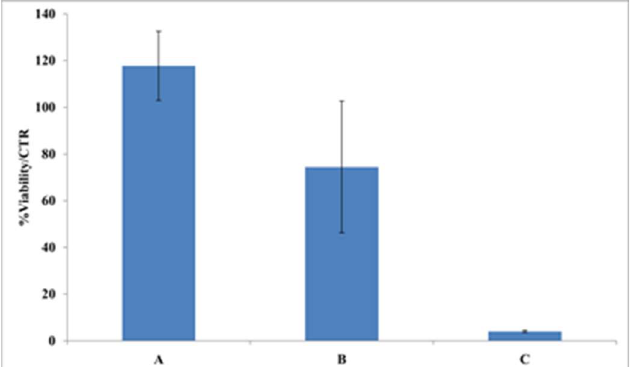
Figure 6. Effects of different concentrations (A, 0.1 mg/mL; B, 1.0 mg/mL; C, 5.0 mg/mL) of argan seed protein concentrate (ASPC)-based films present in the Dulbecco’s modified Eagle’s medium (DMEM) on the viability of immortalized human dermal fibroblast (HDF-hTERT) assayed directly. The absorbance evaluation was carried out after 72 h of treatment. Further experimental details are given in the